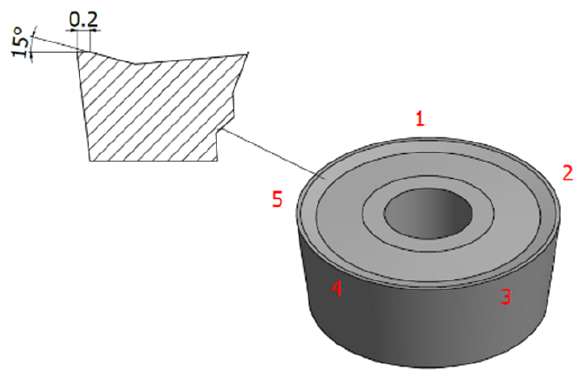
Figure 2. Cutting tool with marked test location [26] (adapted from sandvik.coromant.com).